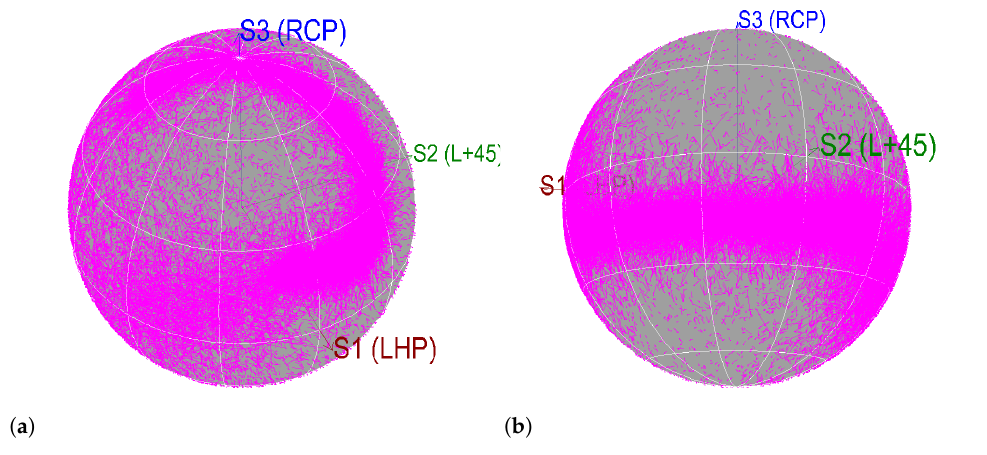
Figure 17. State of polarization before polarization demultiplexing ODN2 ( a ), ODN3 ( b ).